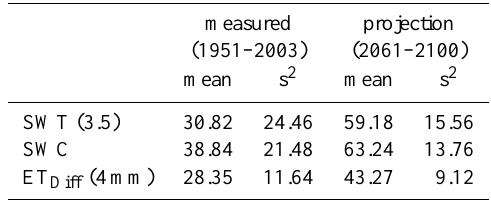
Table 2. Statistical values of drought stress in % according to the indices SWT (3.5), SWC and ET Diff (4mm) for an even site with an AWC of 150mm, for measured and projected climate data (WET- TREG, A1B normal) of the station “Deuselbach”, Germany.